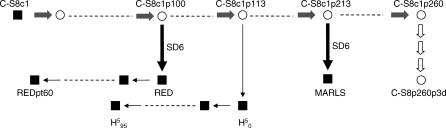
Schematic Representation of the Origin of the FMDVs Used in the Present StudyC-S8c1 is the parental, reference biological clone of FMDV [19]. Biological clones are depicted as filled squares and uncloned populations as empty circles; p followed by a number indicates passage number. Large grey arrows indicate high MOI passages (1 to 5 PFU/cell); thin arrows describe the isolation of biological clones (virus from individual plaques) after dilution of virus and plating on BHK-21 cell monolayers; thick black arrows indicate the selection of mutant RED [20] and MARLS [21], which are resistant to neutralization by monoclonal antibody SD6; large empty arrows indicate low MOI passages carried out to derive the standard C-S8p260p3d genome from a bipartite, segmented form of the FMDV genome termed C-S8p260 [22]. The origin of viruses used in the present study is detailed in Materials and Methods.